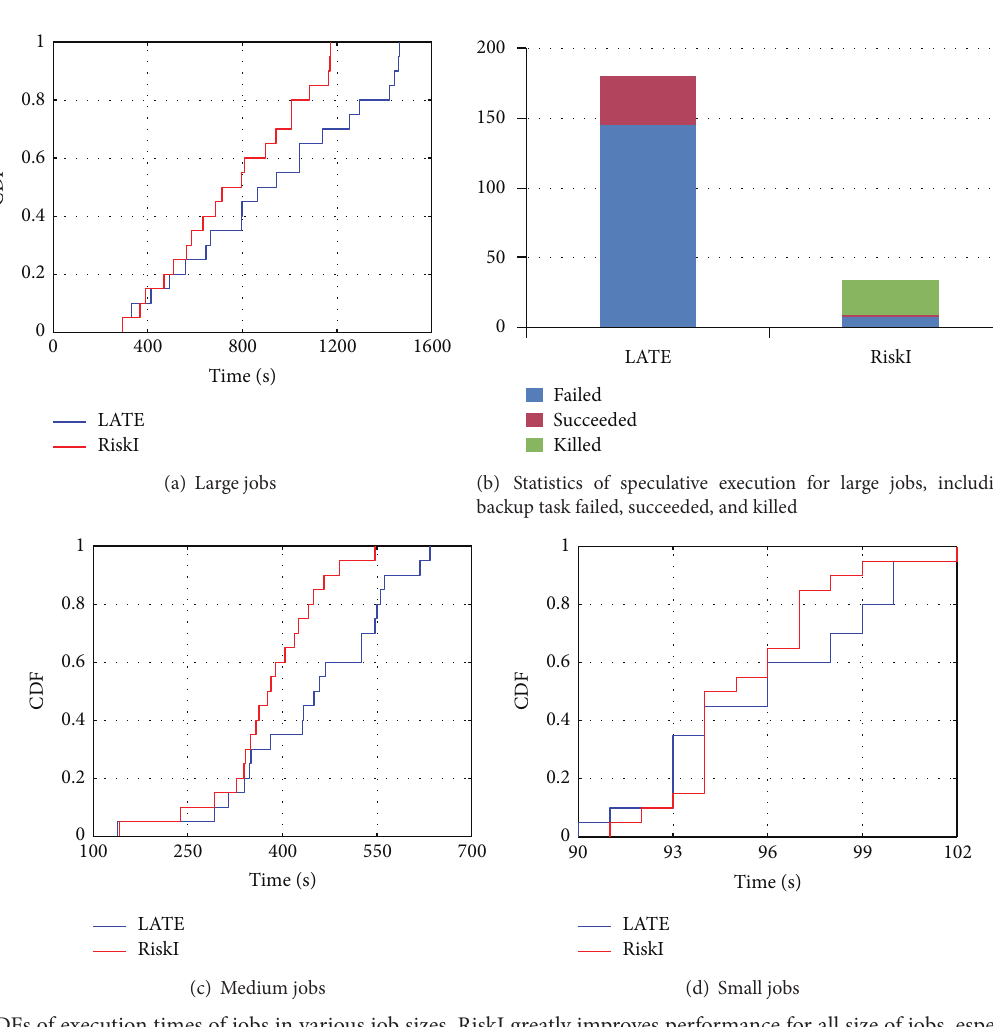
Figure 10: CDFs of execution times of jobs in various job sizes. RiskI greatly improves performance for all size of jobs, especially for large and medium jobs.